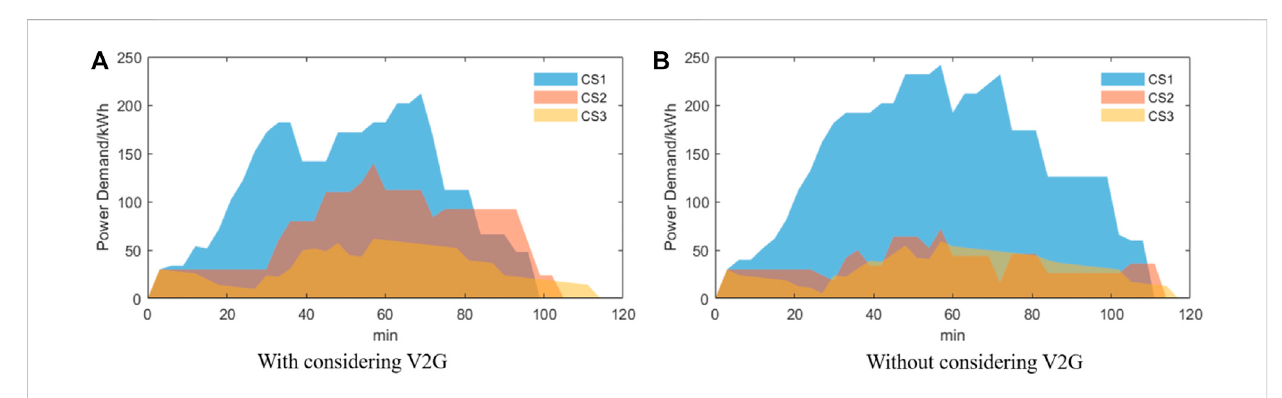
FIGURE 11 Changes in power demand during